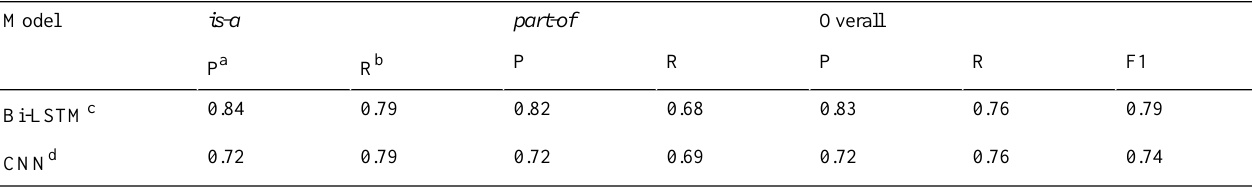
Table 2. Average performances of the parallel concept set (PCS) thread-based algorithm on 100-term